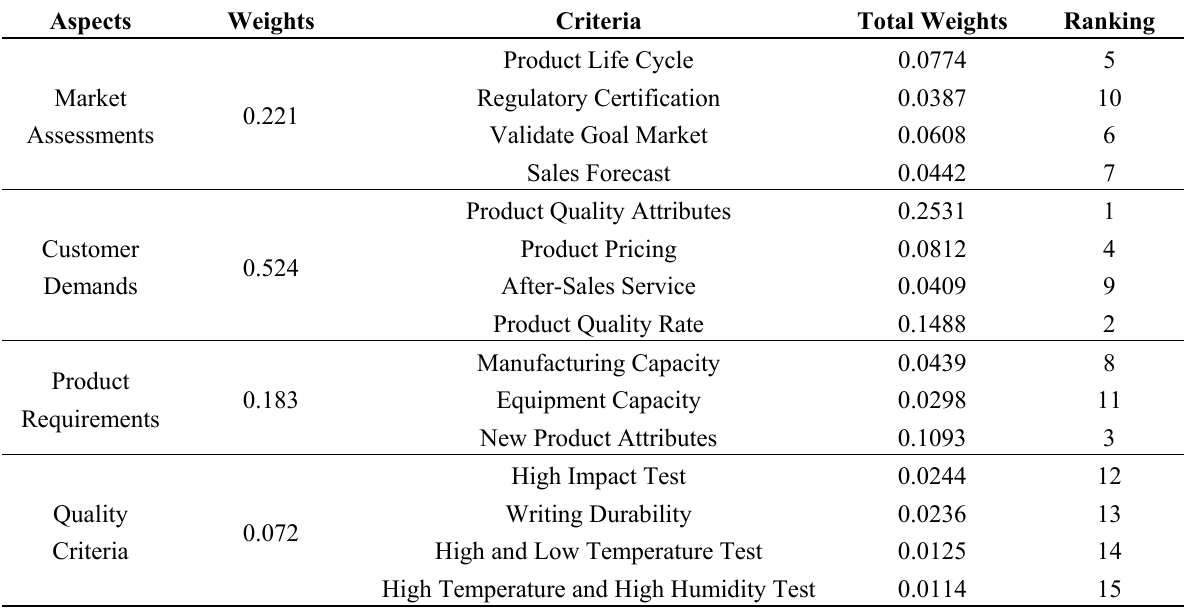
Table 12. Final weights after